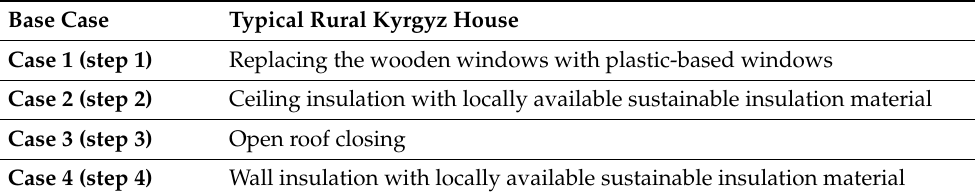
Description of the case studies designed for the